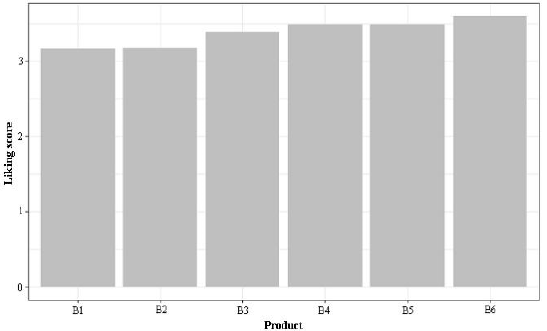
Figure 2. Average liking scores of 76 qualified consumers for six kinds of vinegar. The vinegar code corresponds with Table 1. corresponds with Table